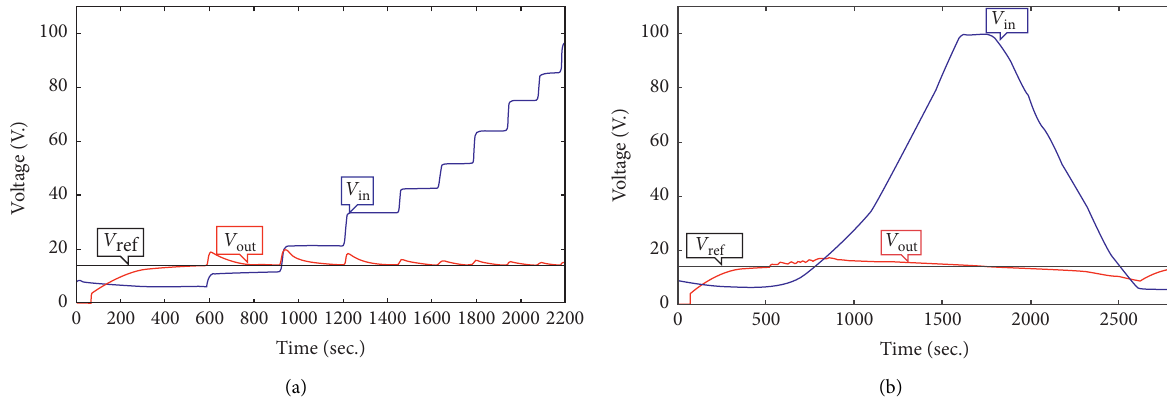
Figure 17: The output voltage response at no load. (a) The input supply voltage stair change varying from 5 to 100V. (b) The input supply voltage varying from 5 to 100V